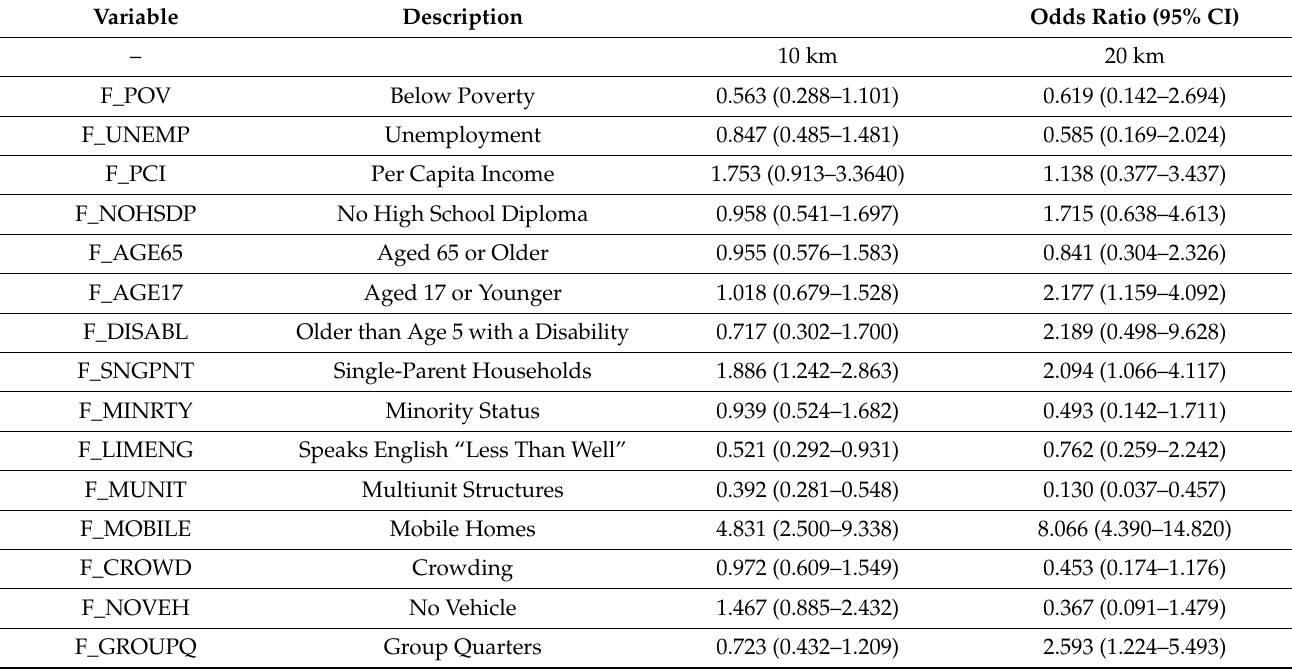
Table 2. Multinomial logistic regression of 90th-percentile SVI variables by spatial scale for not covered, on 15 individual variables (N = 1293 census